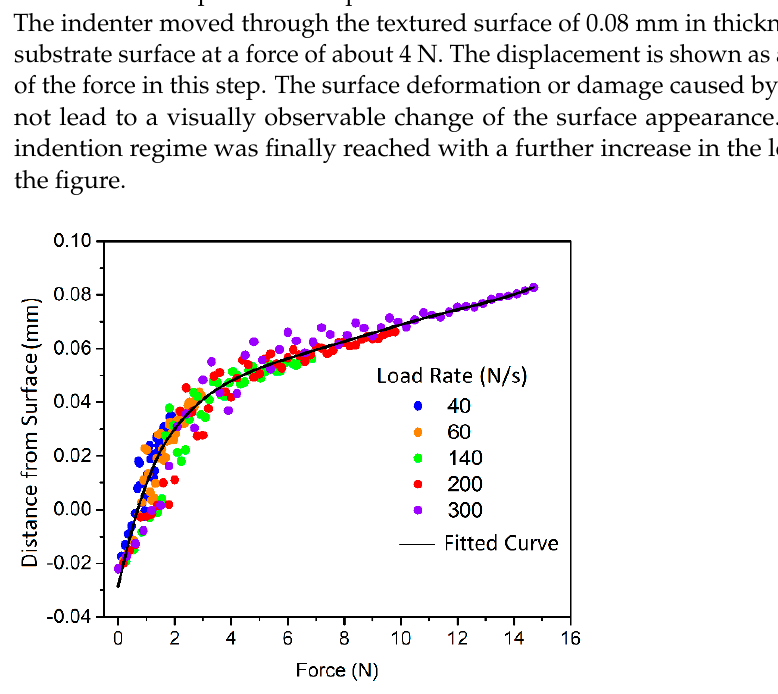
Figure 7. ( a ) Instantaneous resistance coefficient in scratching and ( b ) scratch resistance coefficients of different surfaces. The resistance coefficients were averaged. Figure 7b shows the mean of μ R of rough surfaces CB and SB to different scratch forces. The results show that the surface with tex- ture CB has a higher scratch resistance than the surface SB. This has been demonstrated by the experiments and will be discussed in the following sections. To evaluate the func- tion of the textures in increasing the scratch resistance, the results were compared to a smooth surface. The smooth surface shows a linear relationship of the resistance and the scratch force. It is interesting to note that texture SB resulted in a lower resistance to high scratch forces compared to the smooth force, but a higher resistance to low scratch forces.